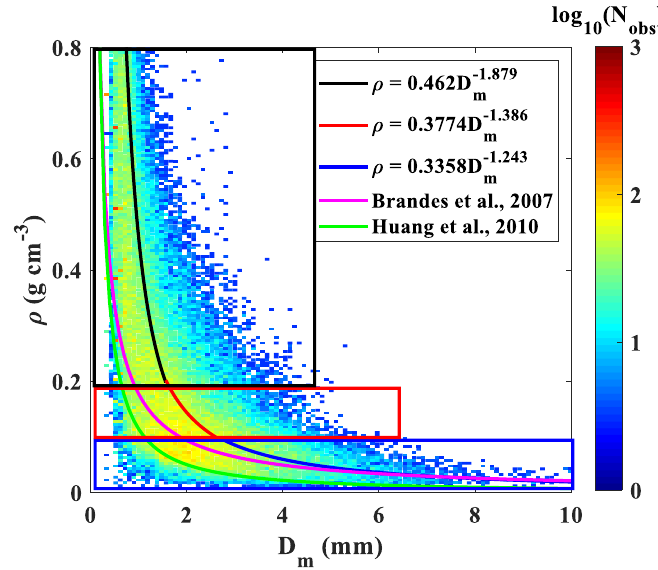
Figure 8. Scatter density plot for ρ (g cm − 3 ) versus D m (mm) and mean ρ - D m power-law fitting for di ff erent ranges. Black fitting is for ρ > 0.2, red fitting is for 0.1 < ρ < 0.2, and blue fitting curve is for 0 < ρ < 0.1.